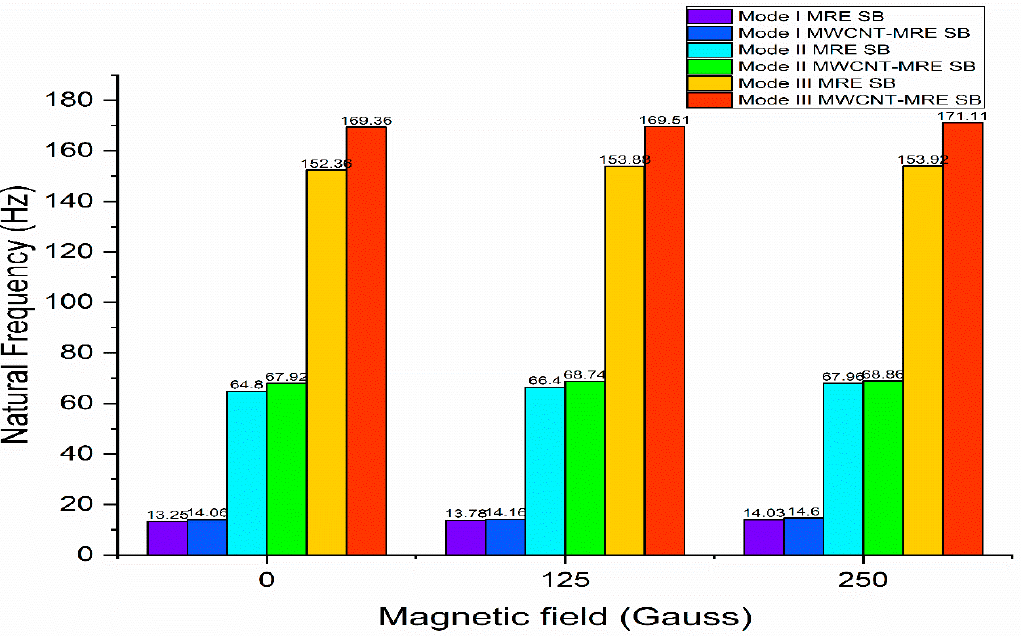
Figure 19. Effect of magnetic field on natural frequency.